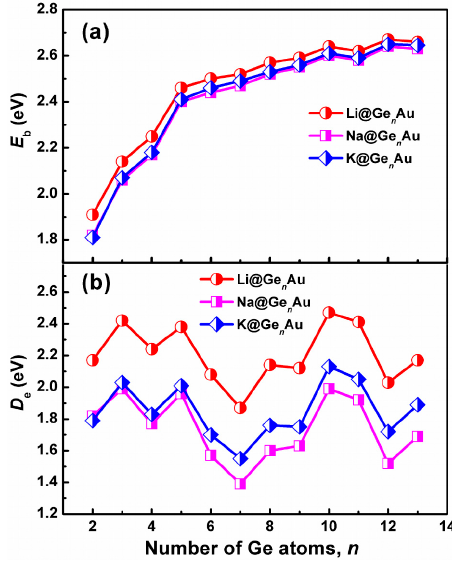
Figure 2. Size dependences of ( a ) the average binding energies ( E b ) and ( b ) dissociation energies ( D e ) for the AM@Ge n Au ( n = 2–13) clusters, obtained by using the hybrid B3LYP functional, in conjunction with the Def-TZVP basis set.